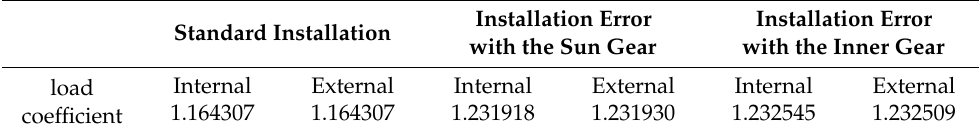
Table 2. Sun gear–planet gear external meshing load coefficient (installation error).